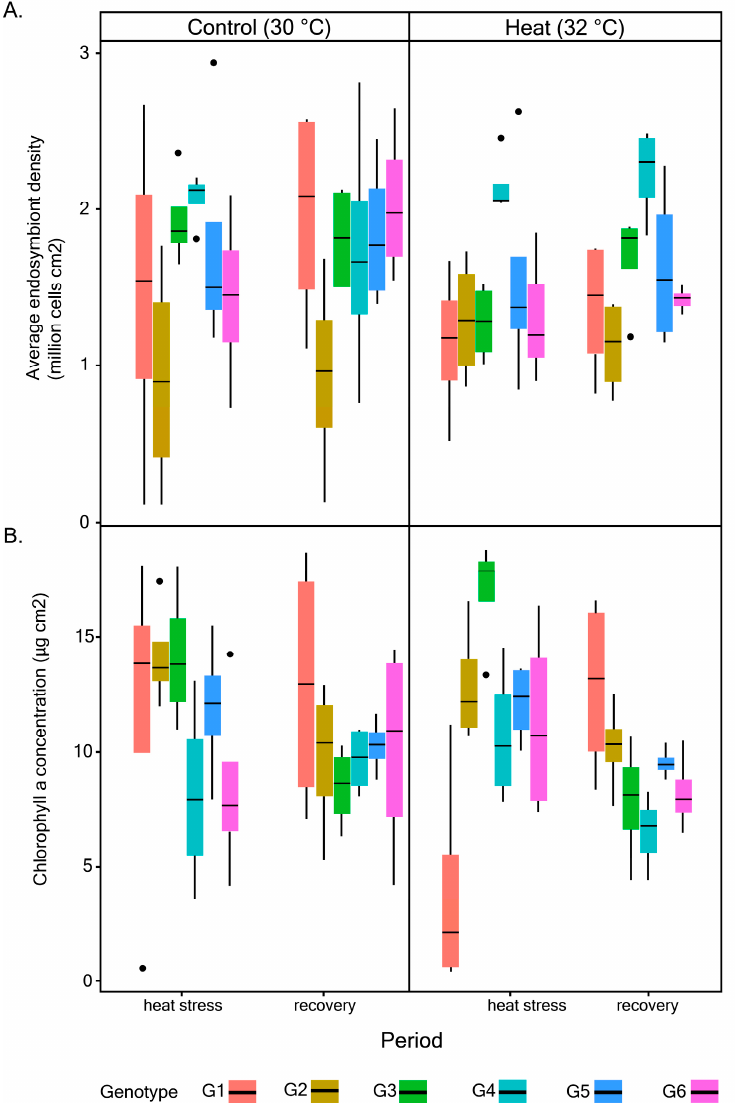
Figure 2. Changes in average endosymbiont density ( A ) and chl a concentration ( B ) for all colonies across experimental conditions.